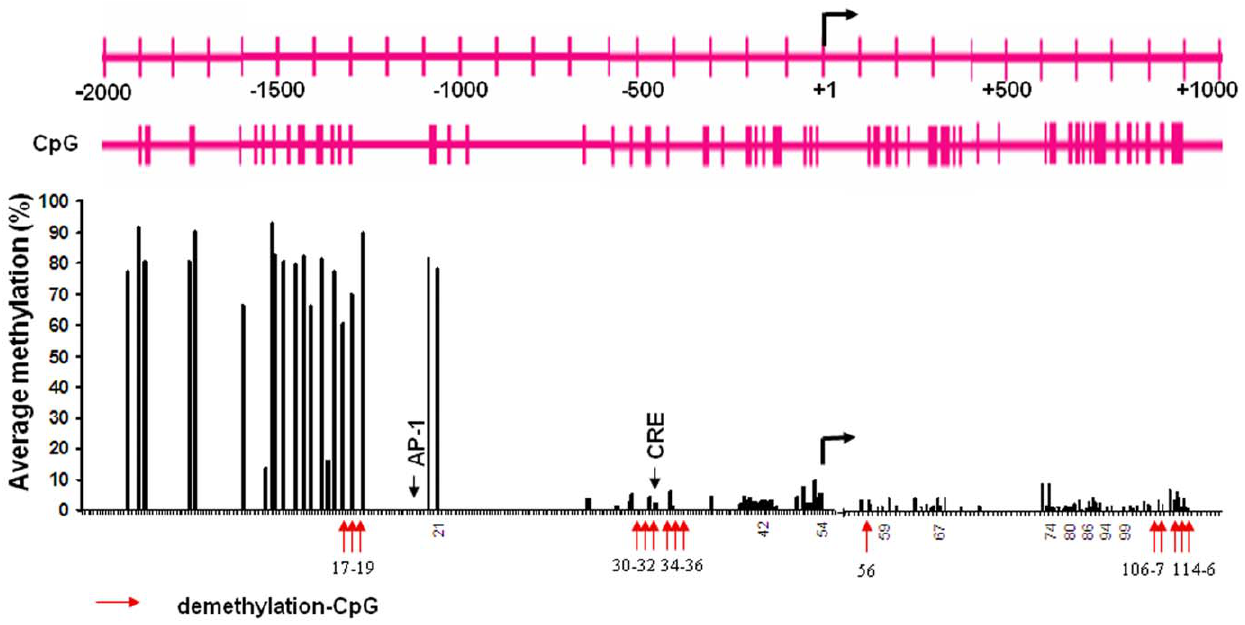
Figure 3. CIE induced DNA demethylation in the specific CpG sites determined by bisulfite-pyrosequencing. This graph outlines the relative CpG positions, where CIE induced significantly demethylation, to the transcription start site and the binding sites of AP-1 and CREB. Methylation status of individual CpG was determined by bisulfite-pyrosequencing at 116 CpG sites in the 5 9 -regulatory area of the NR2B gene. All bars represent the average basal methylation level (%) of individual CpG (control cells). The arrows in red only indicate these CpG sites where CIE induced significant demethylation (the detailed alterations are shown in Figure 4). The locations of transcription factor AP-1 and CREB binding sites are indicated by arrow. The bent arrow indicates the location of transcription start